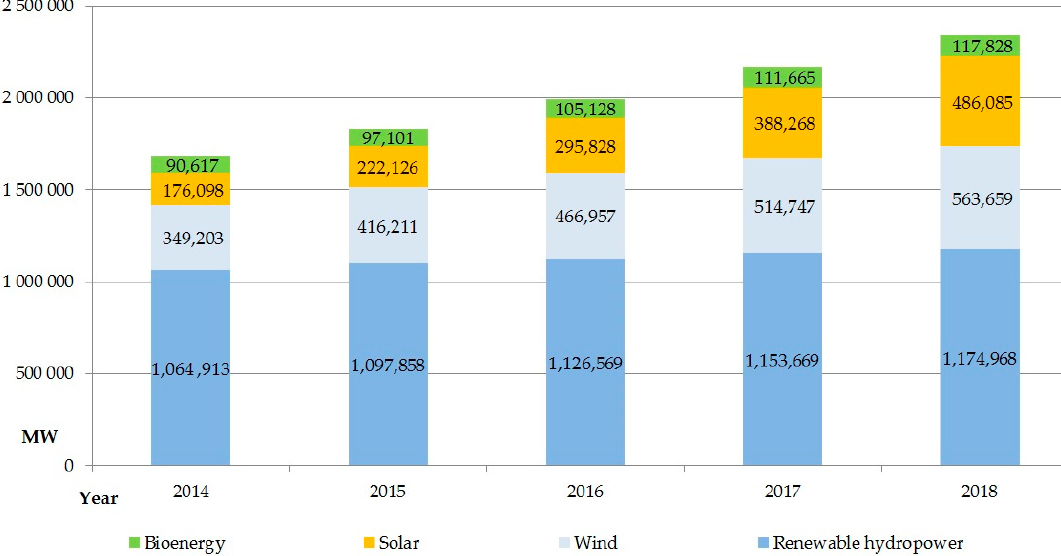
Figure 3. Dynamics of installed capacity of electricity production from renewable sources, megawatt (MW), (2014–2018) [11].